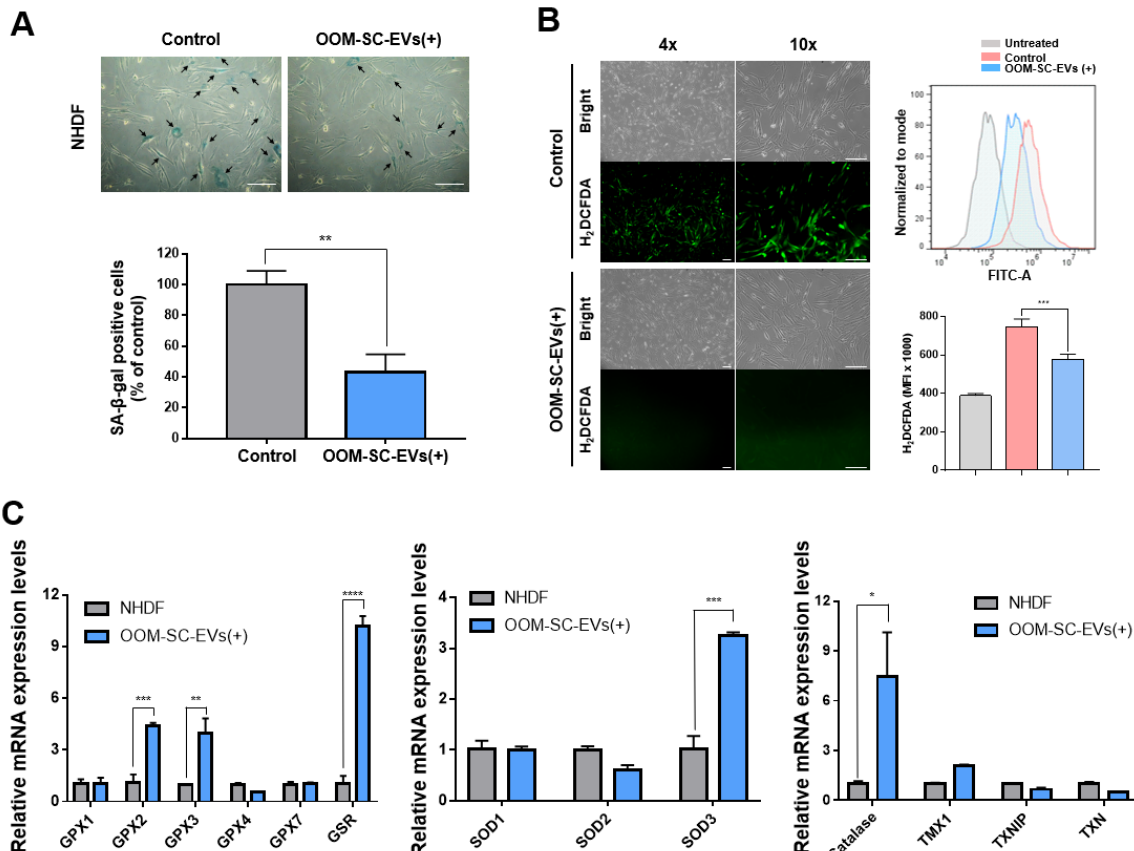
Figure 4. OOM-SC-EVs alleviate senescence-associated changes and modulate ROS generation. ( A ) SA- β gal assay showing a significant reduction of SA- β gal-positive cells after OOM-SC-EV treatment. SA- β gal-positive cells are stained blue. The lower panel graphical data represents the number of SA- β gal-positive cells shown in the upper panel, shown as a percentage of that of the control cells (late passage NHDF). Data are presented as mean ± SD. Statistical significance was determined using Two-tailed t test: ** p < 0.01. Scale bar = 200 μ m. ( B ) Mitigation of ROS generation in OOM-SC-EV-treated late passage NHDF cells. ROS signals were detected via incubation in a 10 μ M H2DCFDA solution for 30 min at 37 °C, followed by observation using a fluorescence microscope. The left panel shows the visualization of ROS green signals using the fluorescent microscope, while the right panels show the FACS-mediated quantitative analysis of ROS generation. Data are presented as mean ± SD. Statistical significance was determined using One-way ANOVA: *** p < 0.001. Scale bar = 200 μ m. ( C ) RT-PCR analysis of the expression levels of antioxidant genes in OOM-SC-EV-treated cells. OOM-SC-EVs significantly increased the expression levels of the antioxidant genes GPX2, GPX3, GSR, SOD3, and catalase. Data are presented as mean ± SD. Statistical significance was determined using Two-tailed t test: * p < 0.05, ** p < 0.01, *** p < 0.001, and **** p < 0.0001.